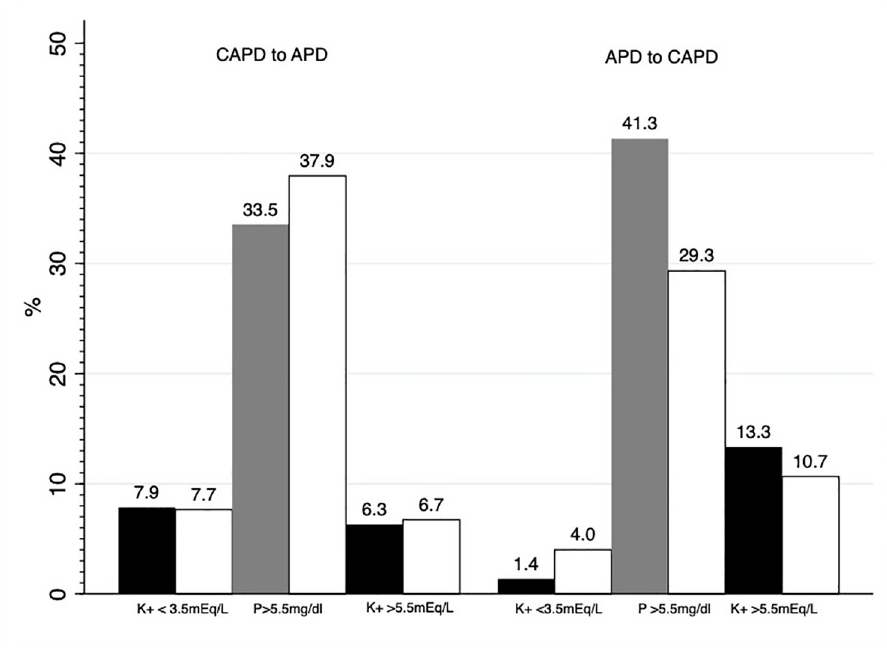
Fig 4. Percentage of patients with hypokalemia (potassium < 3.5 mEq/L), hyperkalemia (potassium > 5.5 mEq/L) and hyperphosphatemia (phosphate > 5.5 mg/dL) before (black/gray columns) and after (white columns) PD modality